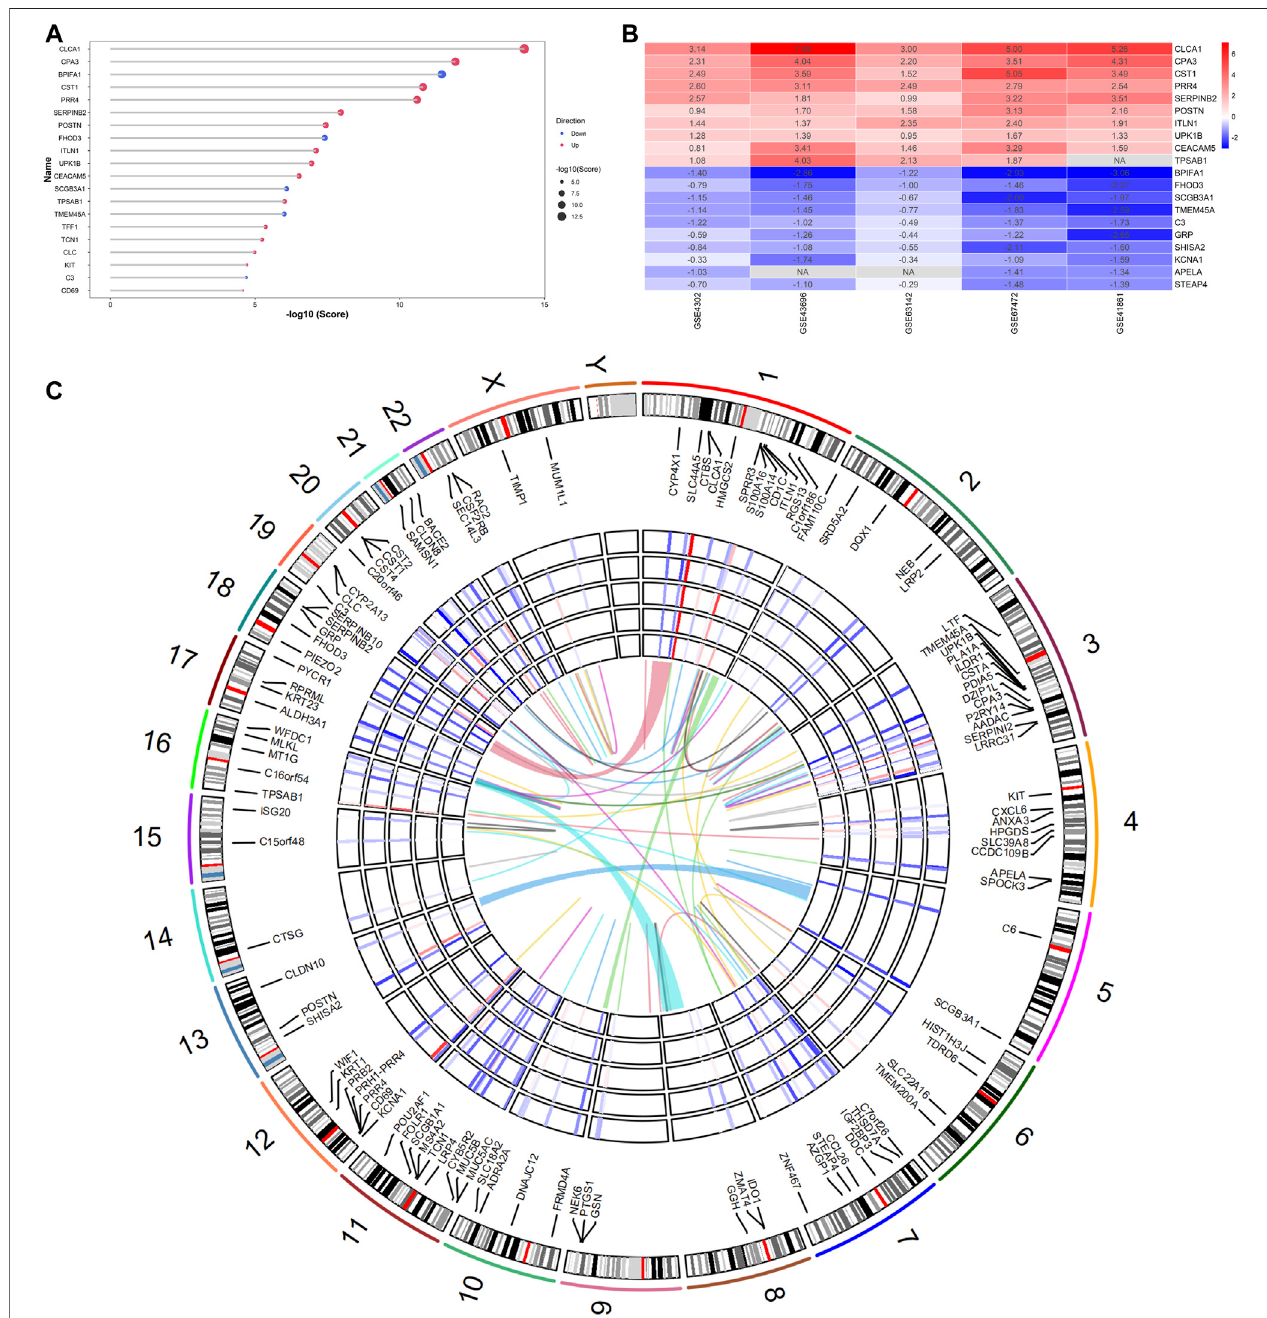
FIGURE 3 | Identi fi cation of robust DEGs in the RRA analysis. (A) The lollipop chart showed the top 20 ranked genes identi fi ed by the RRA method. The red and blue dots represented the up- and down-regulated genes, respectively. Bigger dots represented higher ranks; (B) The heatmap showed the top 10 up- and down- regulatedDEGsin fi veGEOseries.RedrepresentedhighexpressionofDEGsinasthmapatients,whilebluerepresentedlowexpressionofDEGsinasthmapatients.The numbersintheboxindicatedlogarithmicfoldchangesineachdataset; (C) ThecircularheatmapsshowedthechromosomalpositionsofallrobustDEGs.Theouter circle represented chromosomes, while the inner circle heatmaps represented logarithmic fold changes of all robust DEGs in fi ve asthma microarray datasets.